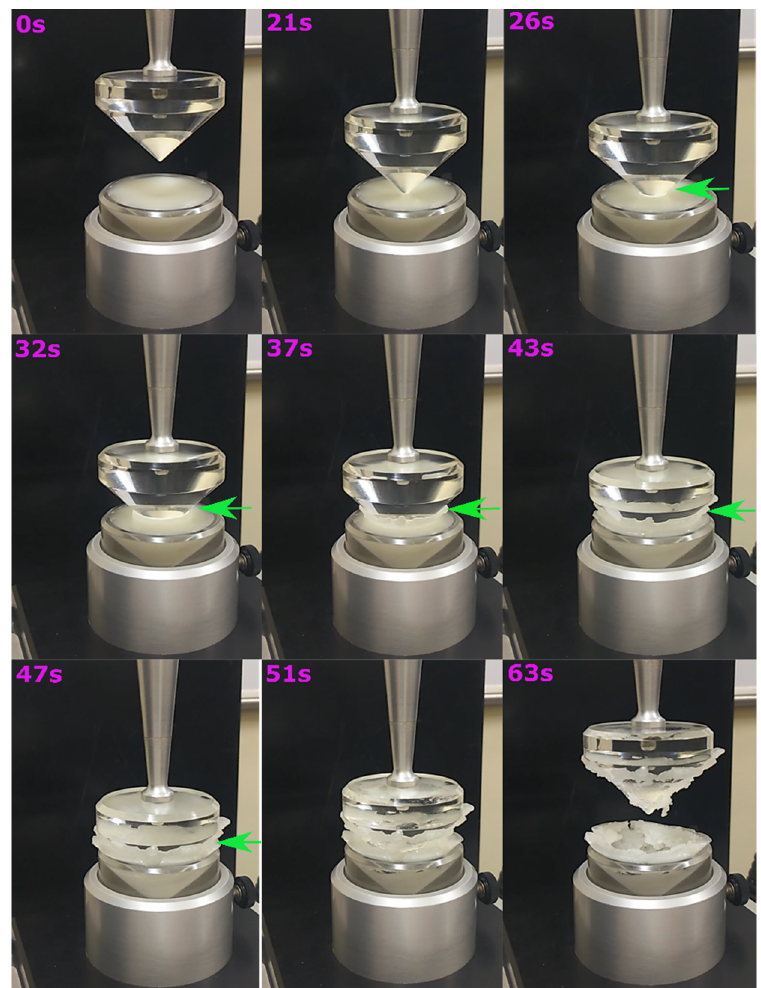
Figure 7. Time-based stages of the spreadability cycle of oleogel indicating its semi-solid nature. The green arrow indicates the increased diameter of the annulus formed by the male cone.